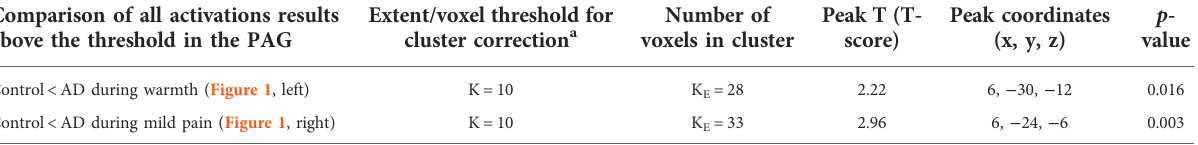
TABLE 3 Group differences in PAG ROI BOLD responses during warmth and mild pain. Comparison of all activations results above the threshold in the PAG